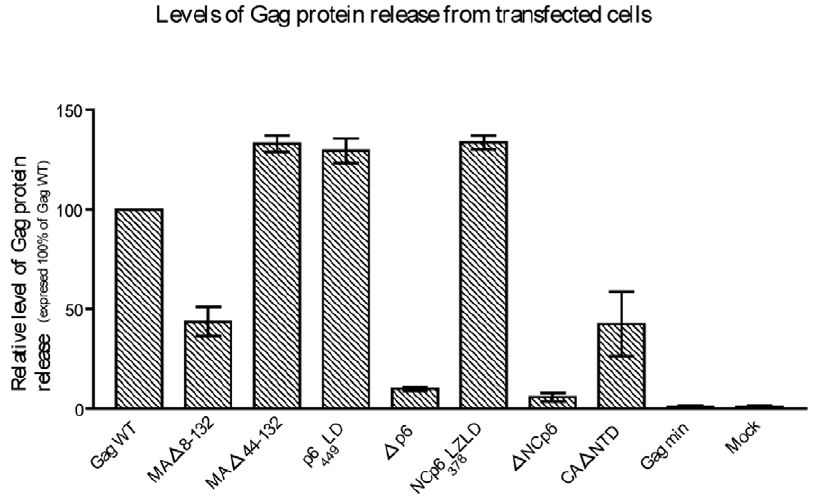
Figure 5. Quantitative analysis of VLP formation. Gag protein signals from cell-free supernatants and cell lysates following transfection with the studied HIV-1 Pr55 Gag -derived plasmids were quantified by scanning the band densities on the WB membranes using a Typhoon 9200 fluorescent laser scanner. Ratios of total Gag protein levels in the cell-free supernatants to those in cells extracts were determined for each construct, and compared with the same ratio for Gag WT. Results shown were obtained by dividing the release ratio for each mutant by the ratio for the Gag WT and multiplying by 100. Data shown represent at least three independent experiments for each mutant. Error bars indicate standard deviations.